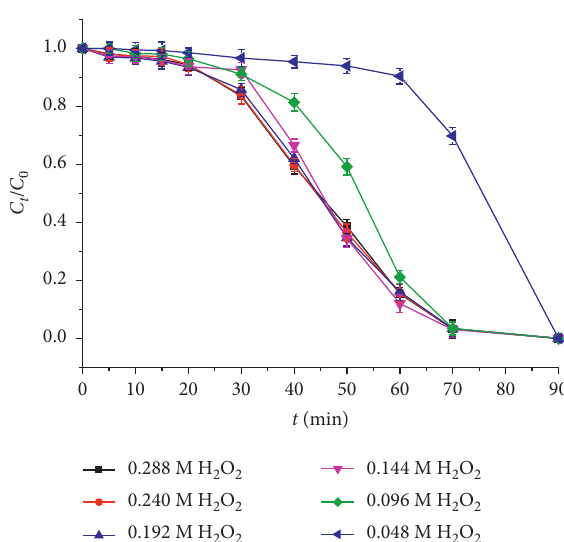
Figure 9: MO degradation profile by the heterogeneous UV/ Fenton-like system via the MIL-53 catalyst at different concen- trations of H 2 O 2 (experimental conditions: 0.5g/L of the catalyst; 40mg/L MO; temperature 30 ° C; UV radiation).